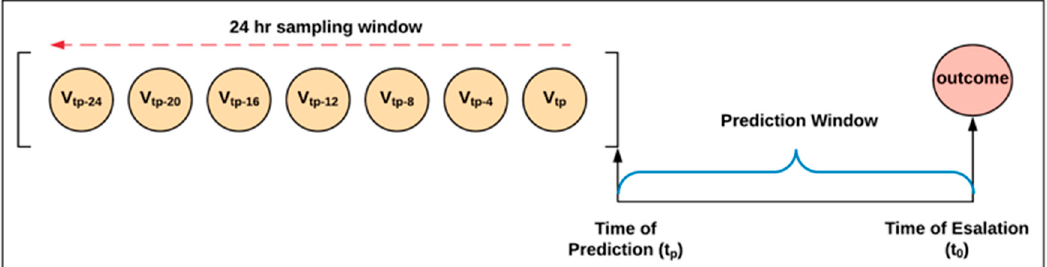
Figure 1. Prediction time and sampling window. t 0 is the time of escalation, death, or discharge for patients with no event. Prediction time t p is the time prior to t 0 at which a prediction was generated. The sampling window is the 24-h period preceding the prediction time t p .